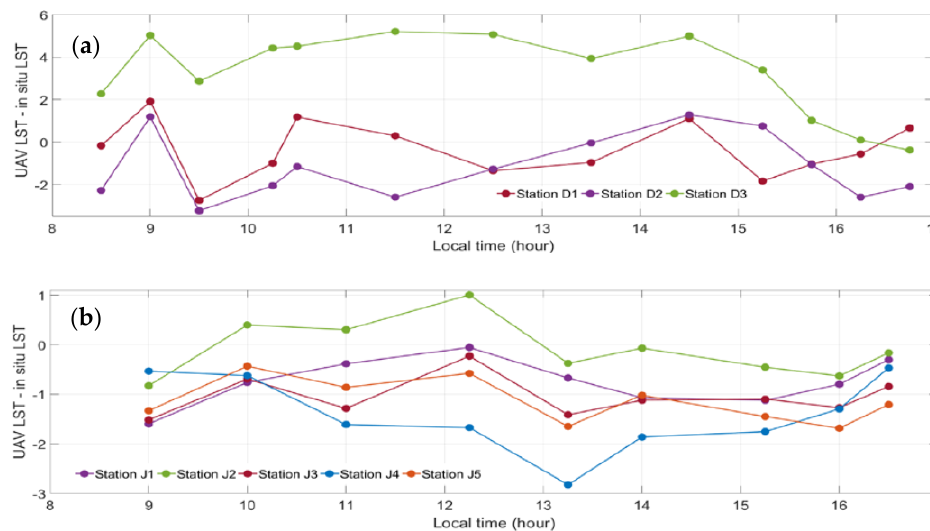
Figure 5. Diurnal temperature difference between UAV-based and in situ measurements for the December ( a ) and January campaigns ( b ).